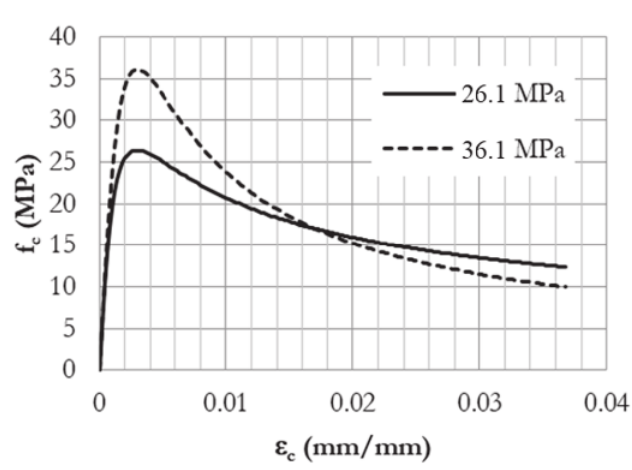
Curva de tensão de compressão versus deformação obtidas para os dos concretos utilizados na modelagem dos